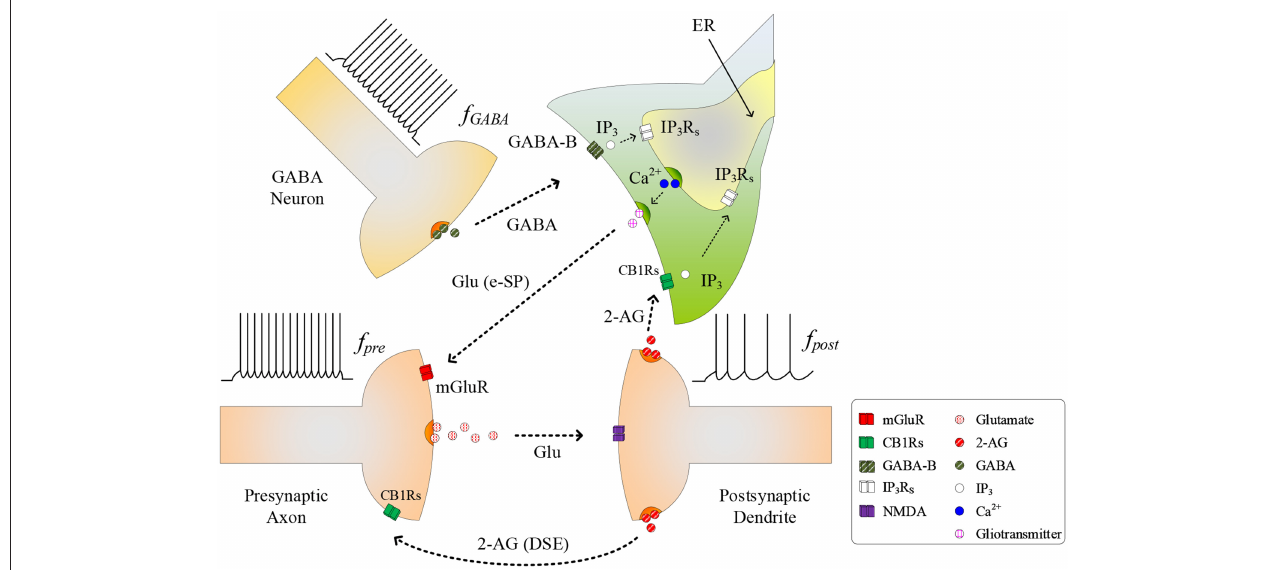
FIGURE 1 | Signaling pathways at the tripartite synapse where GABA released from GABA interneuron binds to GABA-B receptors on the astrocyte membrane and IP GABA 3 is released into the astrocyte cytosol. 2-AG released from the postsynaptic neuron binds to the receptors on the astrocyte membrane triggering the generation of IP AG 3 . With f post low and IP 3 reached a level, IP 3 induces Ca 2 + release from the ER and gliotransmitter is released into the synaptic cleft [Glu (e-SP) pathway] where it binds to mGluR receptors on the presynaptic membrane. This causes an increase in PR and the plasticity window